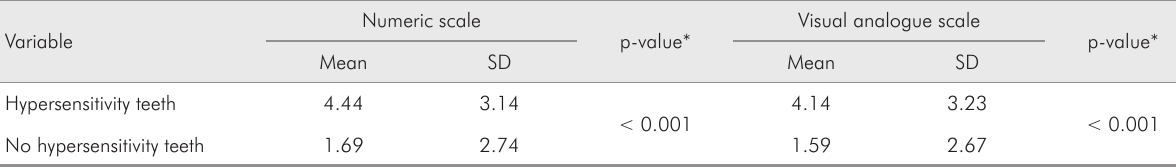
Table 2. Association between hypersensitive teeth and numeric scale and visual analog scale. Variable